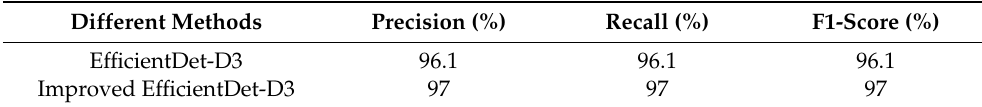
Table 4. Tri-partite measures of original and improved EfficientDet-D3.